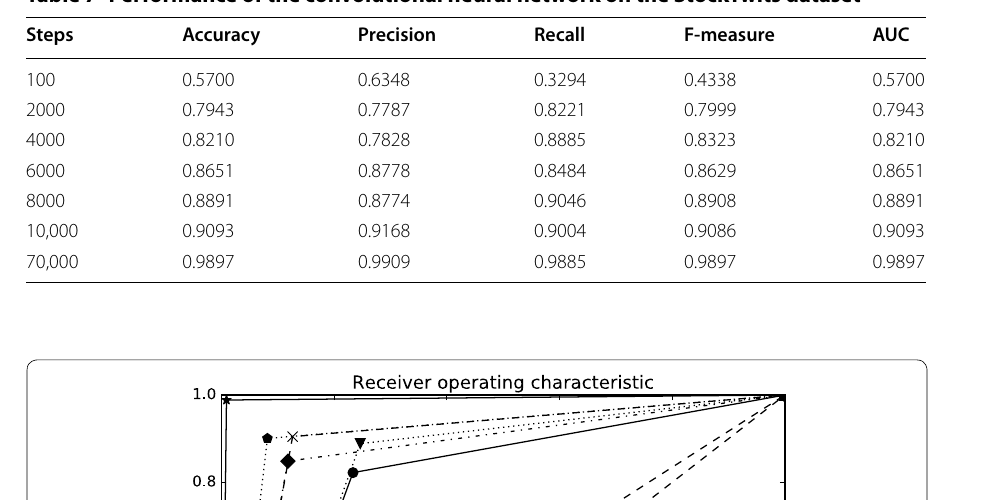
Table 7 Performance of the convolutional neural network on the StockTwits dataset